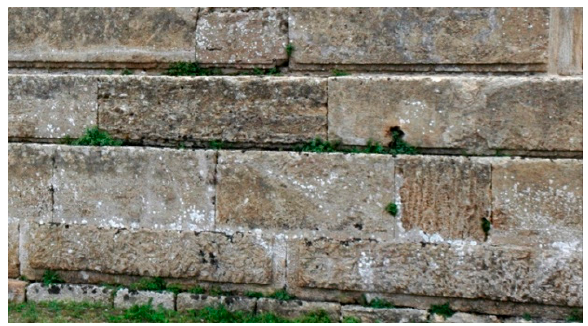
Figure 33. Areas with higher moisture content.